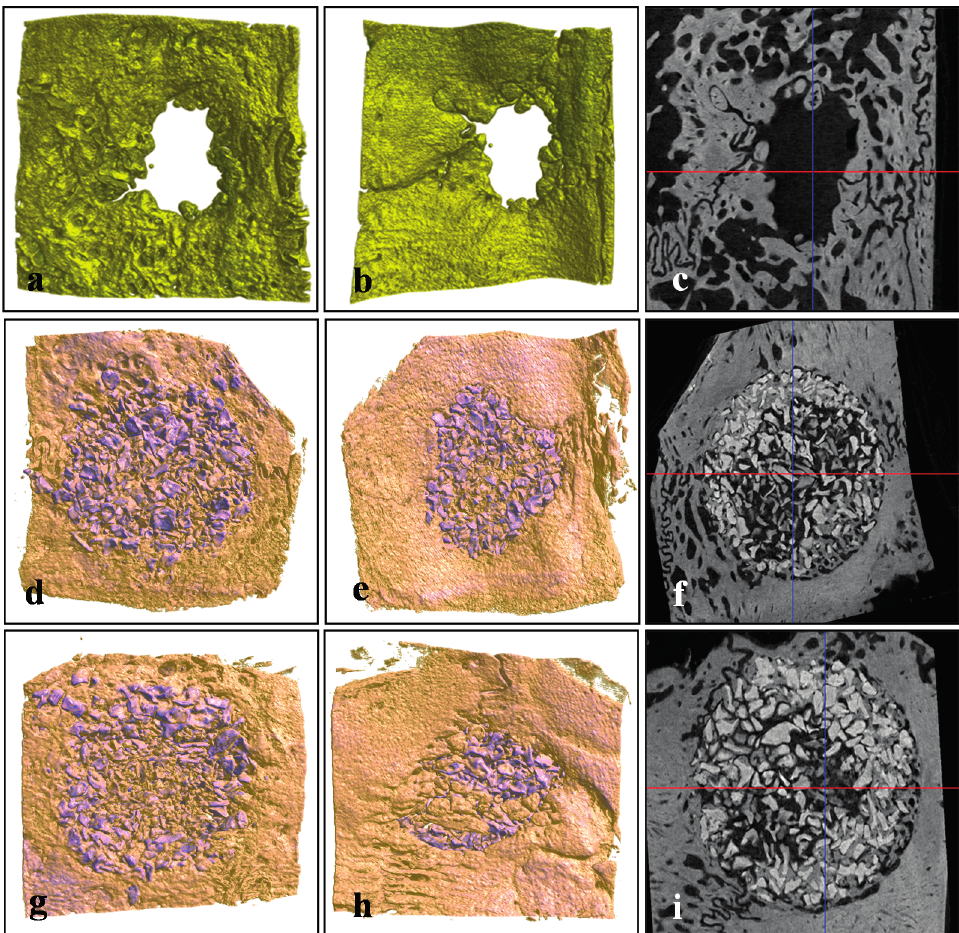
Figure 6. Representative μ CT images at eight weeks after surgery. ( a – c ) controls; ( d – f ) Bio-Oss ® group; ( g – i ) BMP-2/Bio-Oss ® group; ( a , d , g ) outer images of defect sites; ( b , e , h ) inner images of defect sites; ( c , f , i ) horizontally sectioned images of defect sites; Bio-Oss